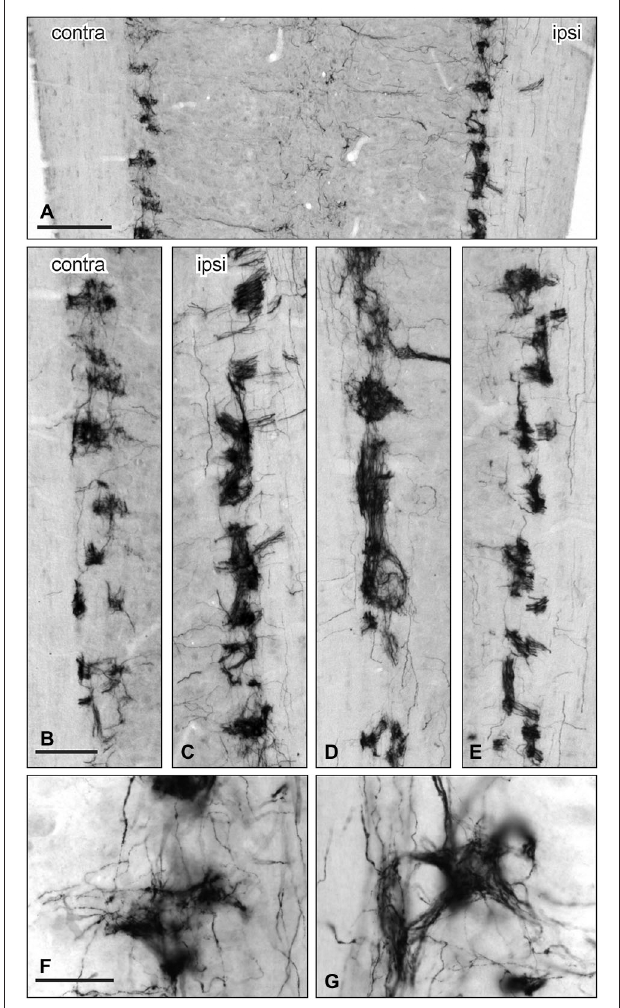
FIGURE 7 | Distribution of GFR α 3-IR in the sacral parasympathetic nucleus (SPN) viewed in horizontal sections following pelvic nerve transection . (A–C) Asymmetric upregulation of GFR α 3-IR in the SPN ipsilateral to a unilateral pelvic nerve transection . (D,E) : Symmetric upregulation GFR α 3-IR in the SPN on both sides following bilateral pelvic nerve transection. (F,G) GFR α 3-IR axons formed dense clusters in the SPN but labeling was not see in somata. Scale bars represent 200 µ m (A) , 50 µ m (B–E) and 50 µ m (F,G)